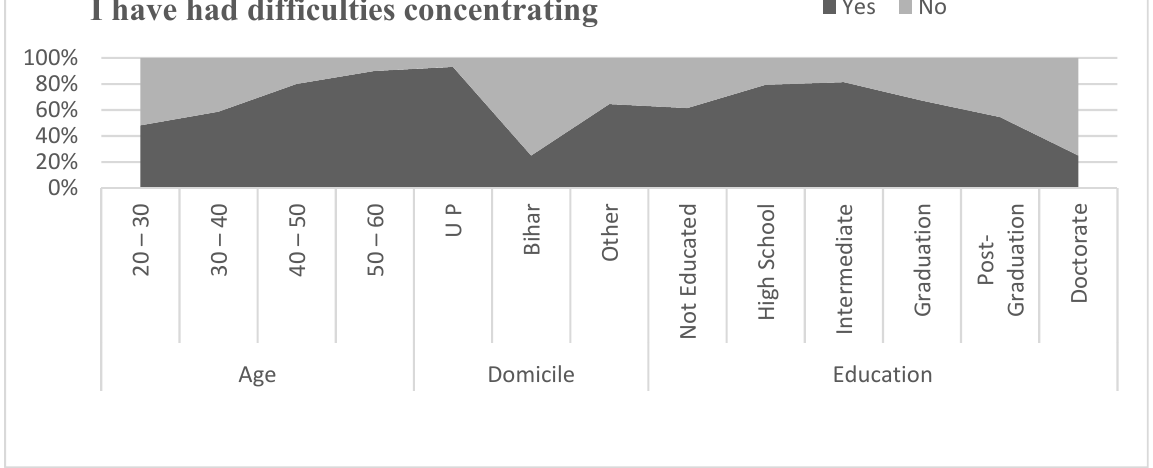
Figure 8. Comparison of having difficulties in concentration.